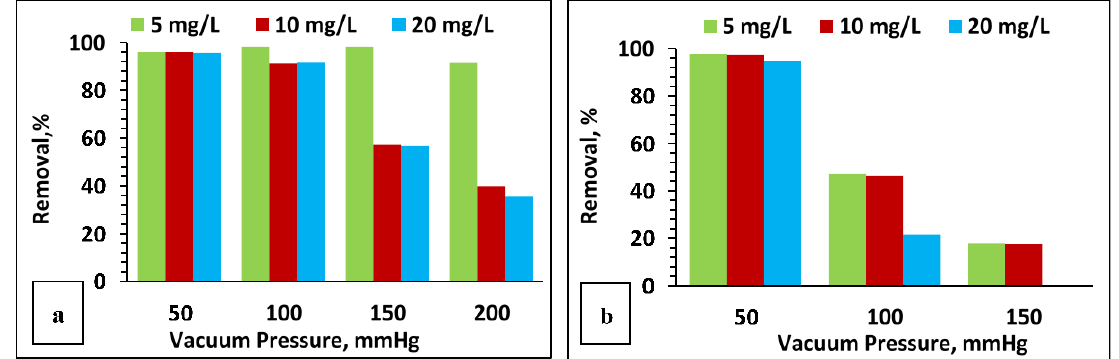
Figure 4. Removal% of dyes from 5 mL solutions at different concentrations, using different vacuum pressures; ( a ) phenol red, ( b ) rhodamine B.